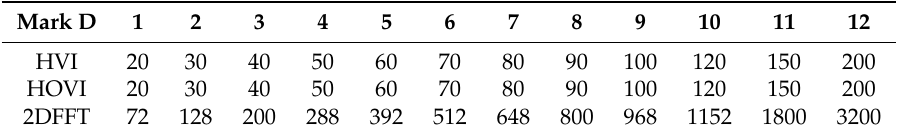
Table 2. The relationship between D and feature dimension